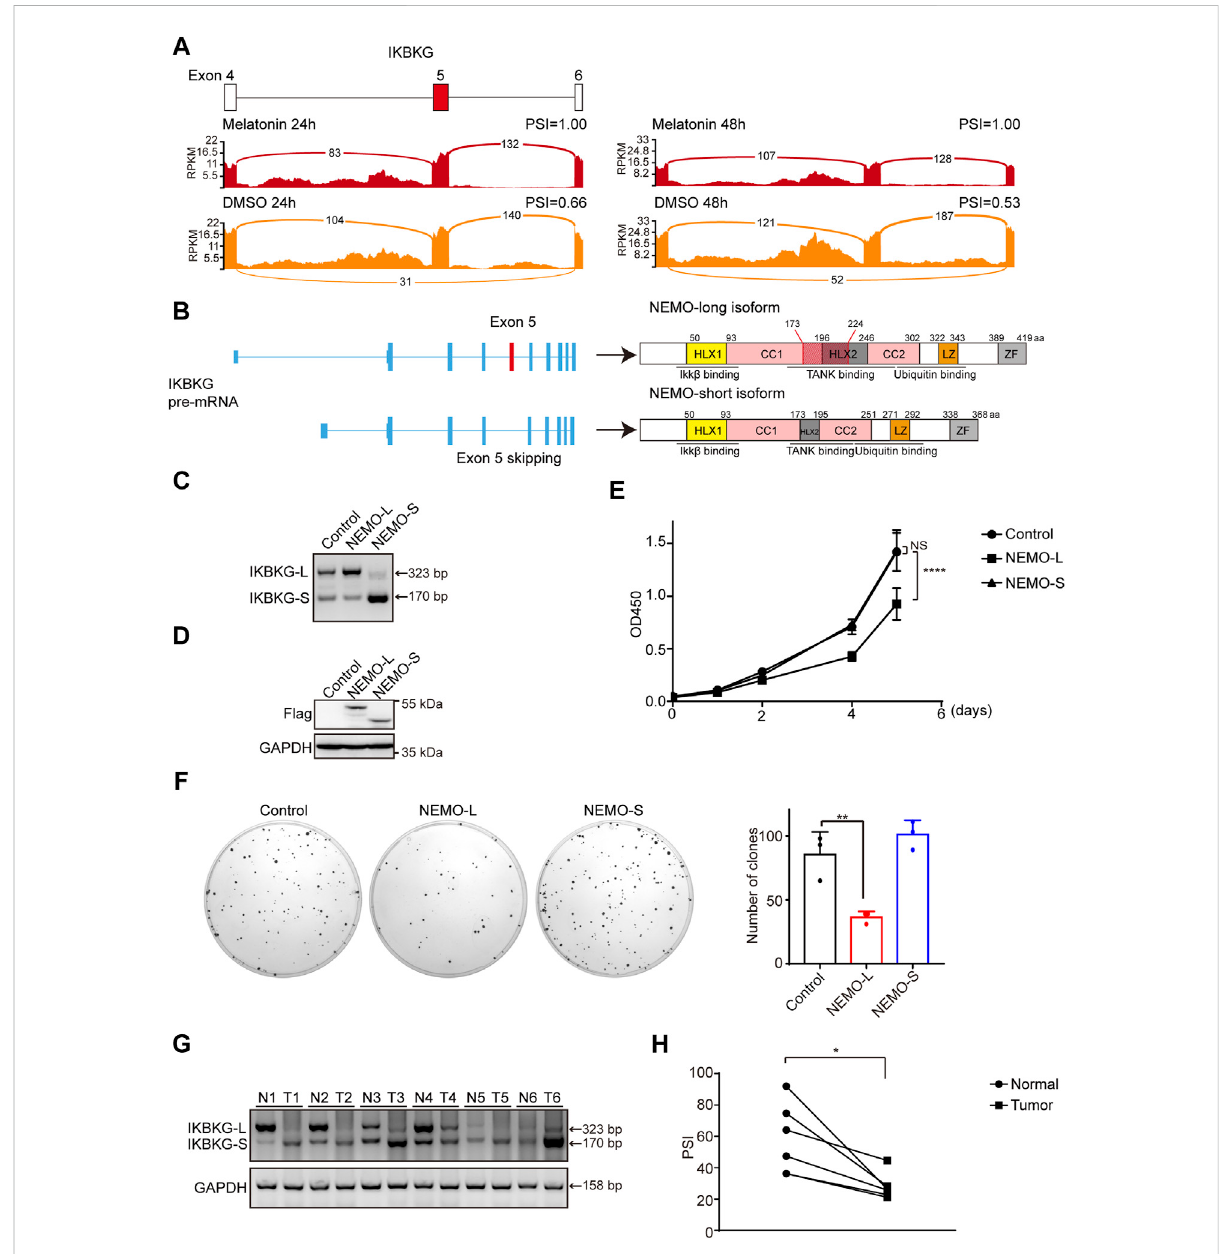
FIGURE 6 NEMO-Linhibitscellproliferation. (A) Alternativeexonof IKBKG affectedbymelatonin.NumbersofexonjunctionreadsandPSIwereindicated. (B) Schematics of human IKBKG (NEMO) pre-mRNA and protein. NEMO-long isoform included the exon 5, while NEMO-short isoform skipped the exon 5. (C,D) HepG2 cells with stable expression of Flag-tagged NEMO-L or NEMO-S were constructed. RNA levels of IKBKG were examined by semi-quantitative RT-PCR (C) . Protein levels of exogenous NEMO were con fi rmed by western blot analysis using anti-Flag antibodies (D) . (E) Cell proliferation of HepG2 cells stably expressing NEMO-L or NEMO-S were analyzed by CCK8 assay at intervals, with p values calculated by two- way ANOVA. (F) Colony formation assays of HepG2 cells stably expressing NEMO-L or NEMO-S. Images of the whole plate are shown. The mean ± SD of relative colony numbers was plotted ( n = 3) and p values calculated by one-way ANOVA. (G,H) Alternative splicing of IKBKG were measured in six paired liver cancer tissues and adjacent normal tissues by semi-quantitative RT-PCR. PSI values were plotted. * Indicated p <